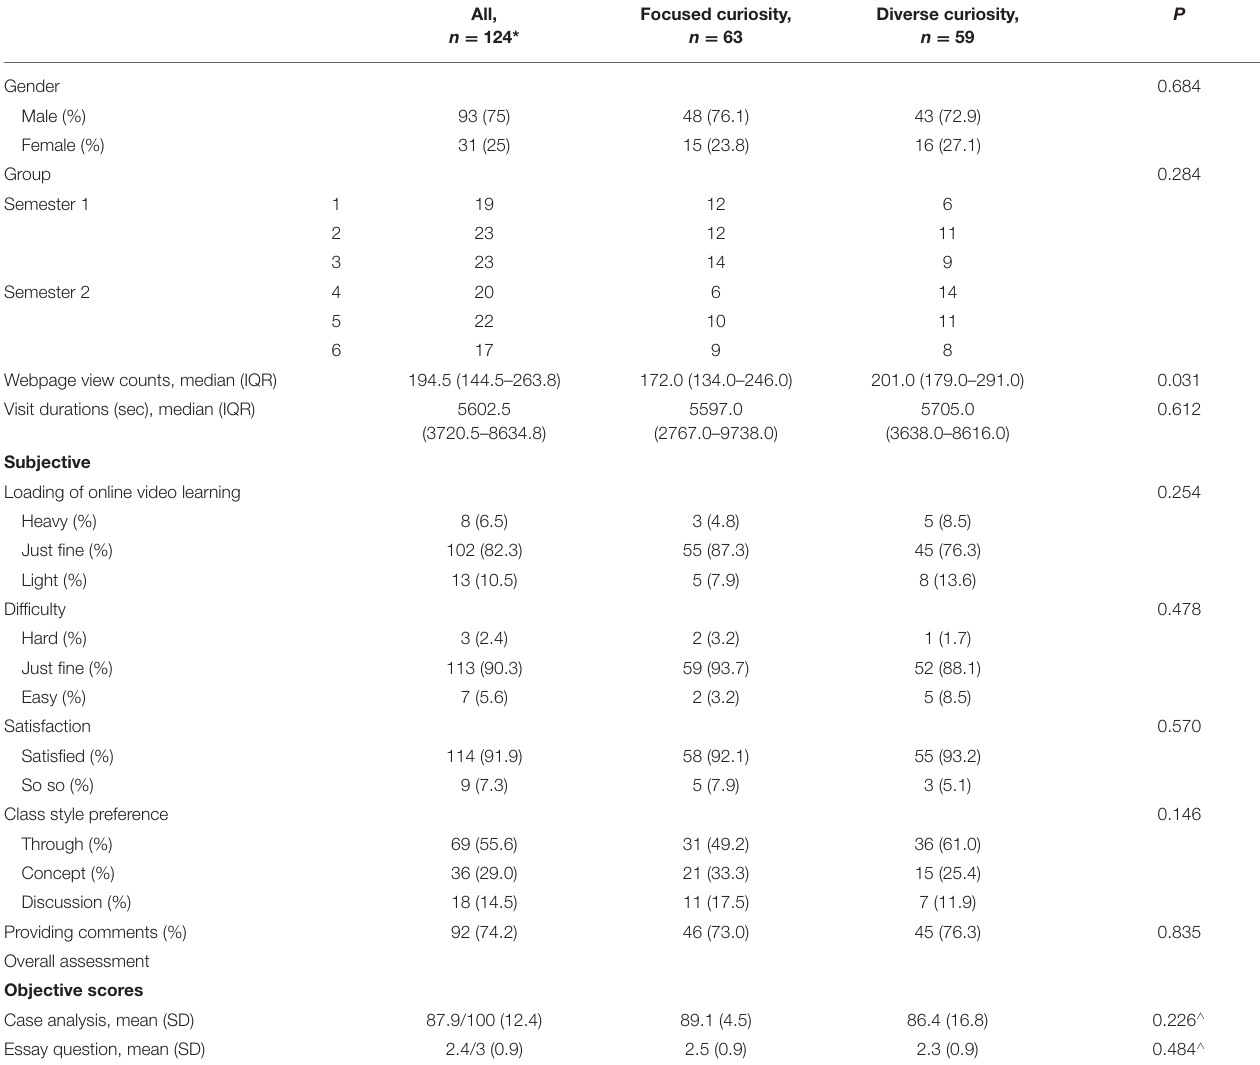
TABLE 1 | Characteristics of Participants Taking Surveys (Mann–Whitney U or chi-square